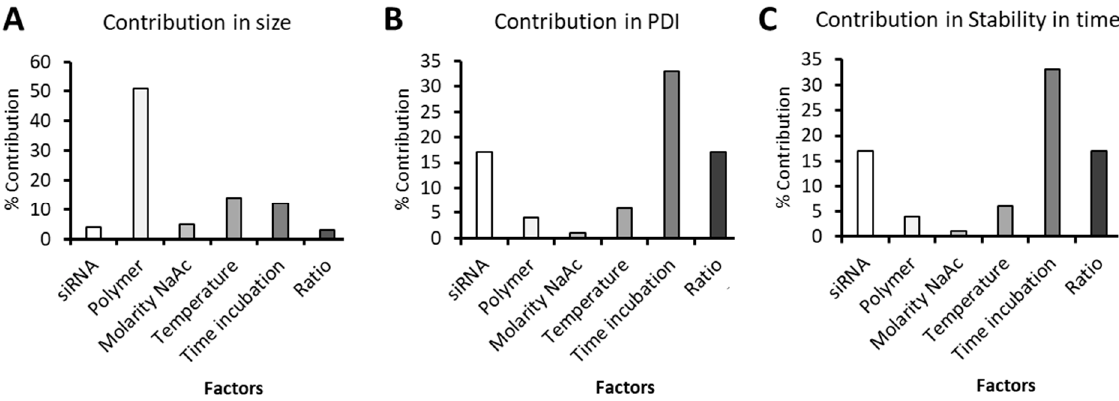
Figure 2. Results of the DoE. Contributions of the factors (in %) on: ( A )—Size; ( B )—PDI and ( C )—Stability in time.